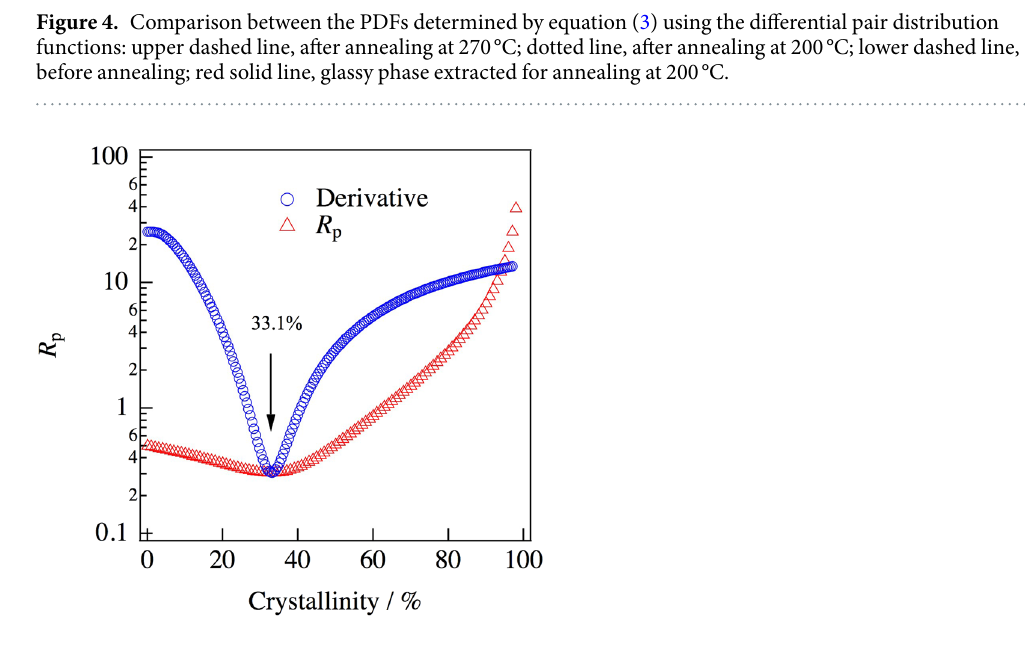
Figure 5. Reliability factors, R p , for the extracted glassy phase based on the crystallinity: red triangles, R p ; blue circles, derivative of R p .